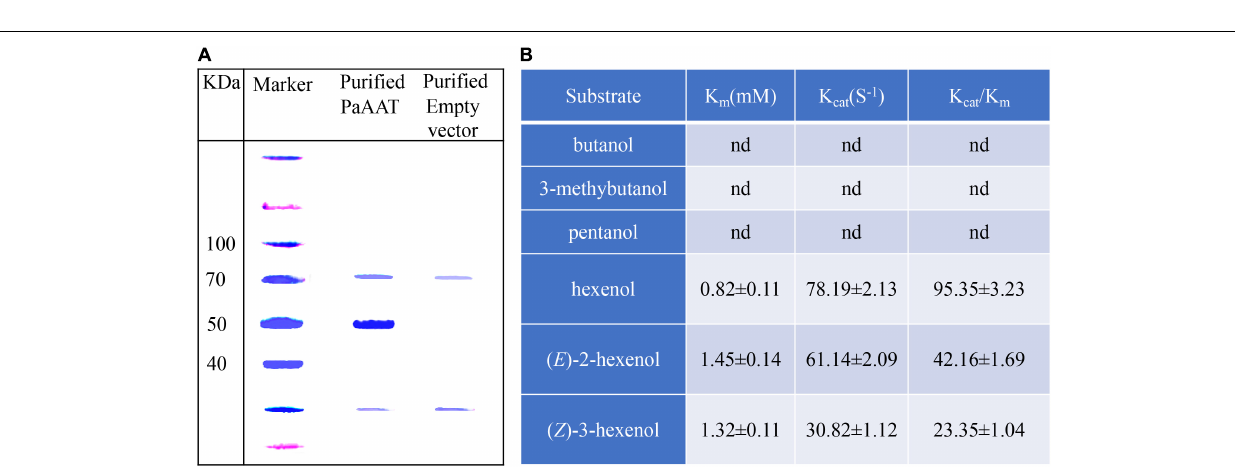
Frontiers in Plant Science |